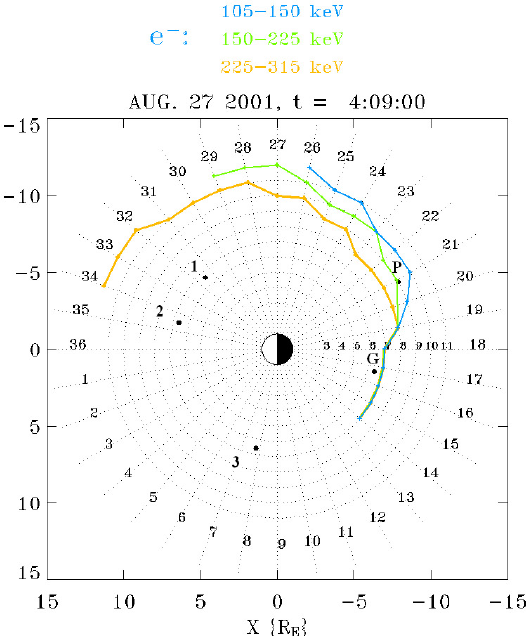
Fig. 2. Locations at which an electron flux increase was observed in the simulation, in the 225–315keV energy channel (yellow line), 150–225keV (green) and 105–150keV (dark blue). At the locations where the three lines coincide the flux increase occurs simultane- ously at all three energy channels (electron dispersionless injection